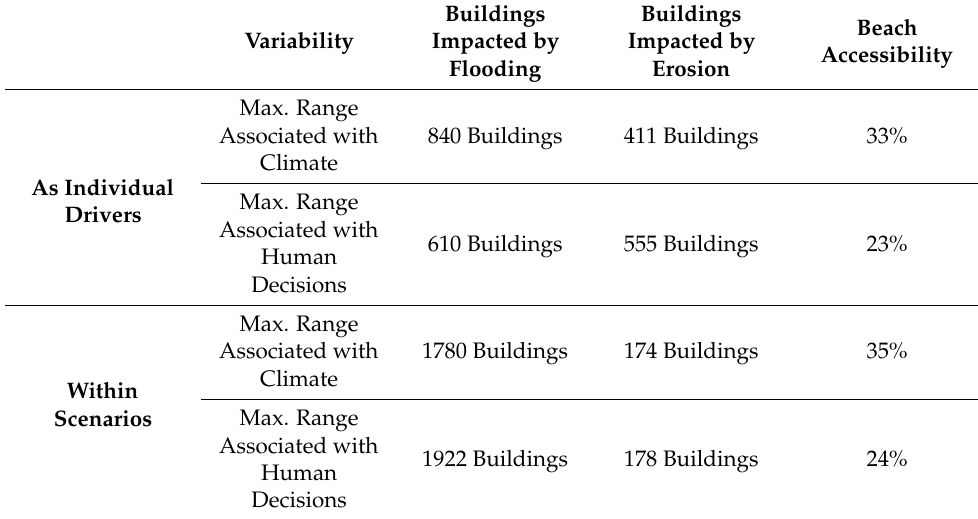
Table A1. Maximum ranges of three landscape performance metric values associated with climate and human drivers. As individual drivers, the range is measured by the maximum absolute difference from the baseline value in any year during the 90-year time series. Within scenarios, the range associated with climate is computed as the maximum range of the high and low climate impact means within any of the four policy scenarios and the range associated with policy is the greatest difference between the mean of the maximum metric value of all policy scenarios and minimum metric value of all policy